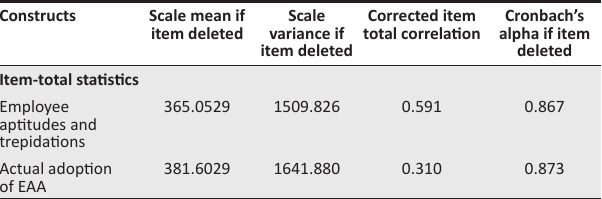
TABLE 2: Cronbach’s Alpha per construct. Constructs